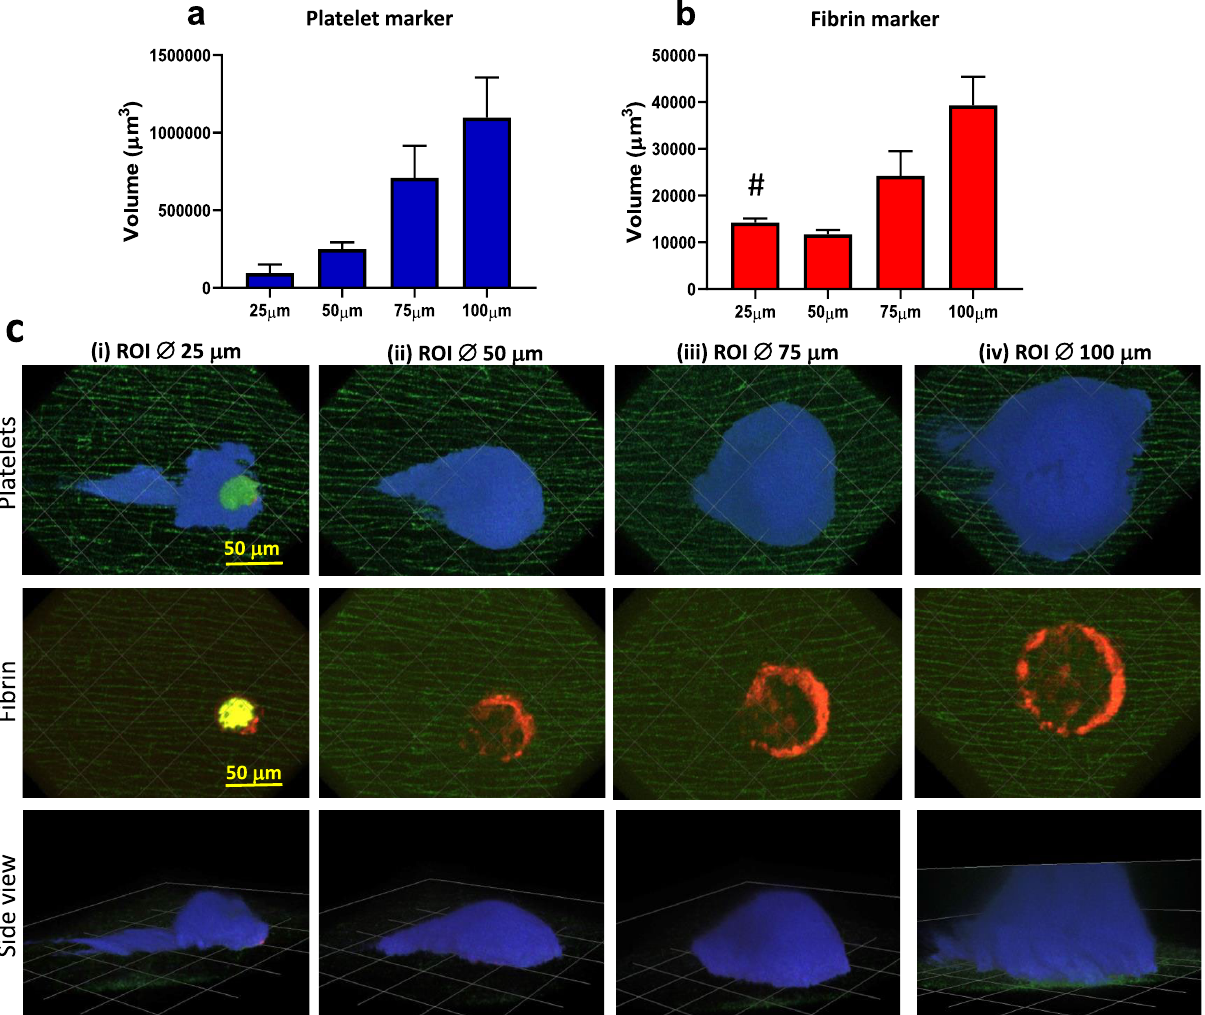
Figure 4. Optimisation of scanning-LIEI injury size (ROI diameter). Injuries were generated using different sized scanning ROIs. ( a ) Quantification of platelet volume 5 min after injury using different ROI diameter (25 μm, 50 μm, 75 μm, or 100 μm). ( b ) Quantification of fibrin volume 5 min after injury using different scanning ROI diameter (25 μm, 50 μm, 75 μm, or 100 μm) (n = 3–11 injuries from 3 to 5 mice). ( c ) Representative XY surface 3D reconstructions of thrombi (platelets blue, fibrin red), and autofluorescent elastin layer (green). Blood flow is from right to left. Top row: platelet accumulation 5 min after injury. Middle row: Fibrin formation 5 min after injury. Bottom row: Thrombus side view (YZ 3D surface reconstruction) 5 min after injury. The ROI diameter was (1) 25 μm (note the autofluorescence of damaged tissue in the 488 nm (green) and 546 nm (red) channels (seen as yellow in the fibrin image) causing an artificially high signal in the fibrin (564 nm) channel (#) (see also Supplementary Fig. 1C) (2) 50 μm (3) 75 μm or (4) 100 μm. Note the height of the thrombus exceeding our 100 um piezo stage Z-range limit when using the 100 um ROI. Scale bar and grid size 50